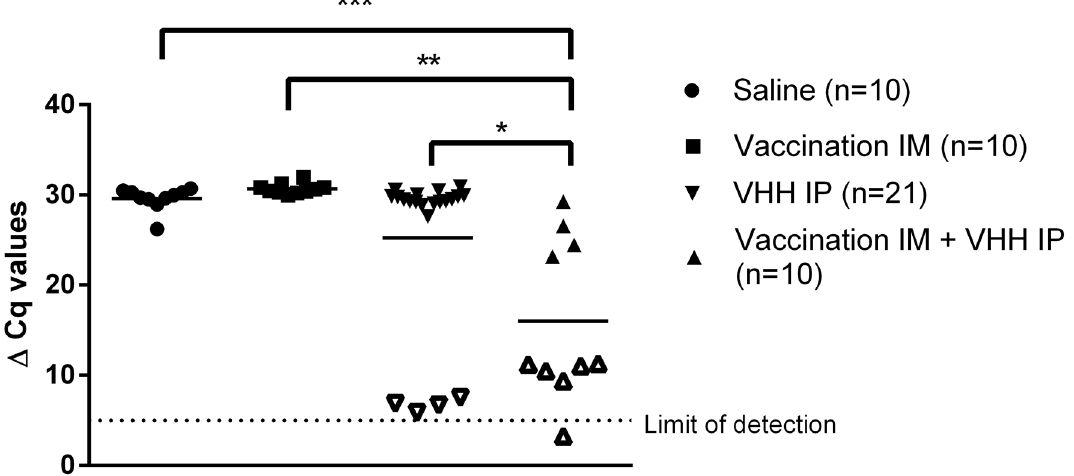
Fig 5. Post-exposure treatment with vaccine and anti-rabies VHH: Effect on the viral RNA load in the brain of mice. The viral load was determined at the peak of clinical symptoms in mice that developed disease (filled symbols) or at the end of the observation period (open symbols) in survivor (non-diseased) mice. The dashed line represents the limit of detection (= 5 Δ Cq). Mice treated with vaccine + VHH had significantly lower viral RNA loads than na ï ve mice (p < 0.0001), mice treated with vaccine only (p < 0.001) or mice treated with VHH only (p < 0.05). Viral loads of diseased mice were also lower (25.85 Δ Cq) in mice that were treated with vaccine + VHH compared to na ï ve mice (29.58 ± 1.29 Δ Cq) or treated with VHH only (29.59 ± 0.76 Δ Cq). Survivor mice (vaccine + VHH, VHH alone) had comparably low viral loads (3.3 – 11.3 Δ